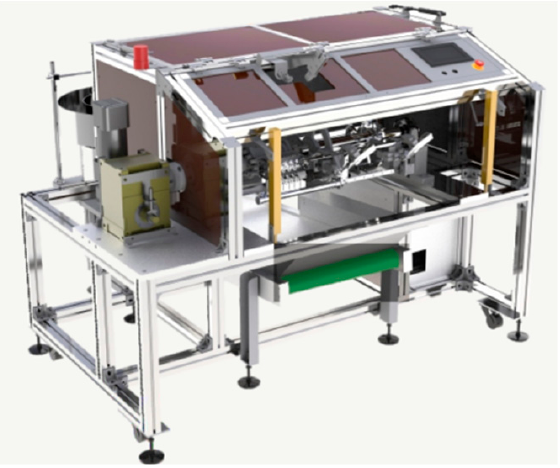
Figure 2. JFT-A1500T semi-automatic grafting robot developed by Hefei Jiafute Robot Technology Co., Ltd.